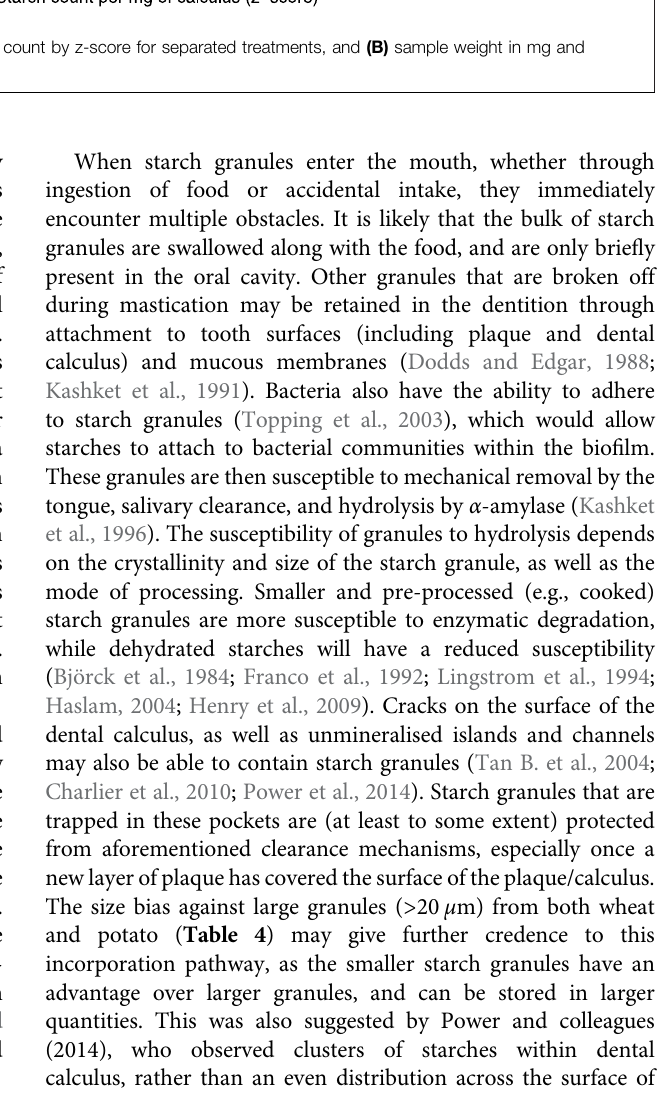
Frontiers in Earth Science |